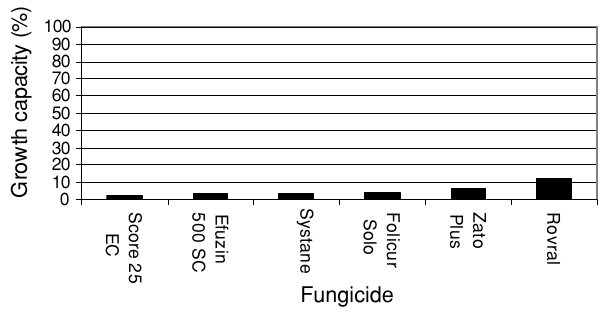
Figure 2. Percent growth capacity of Spilocaea pomi for 6 fungicides (approved in integrated production) admended on PDA plates at 1 × dosage recommended by the manufacturer (LSD